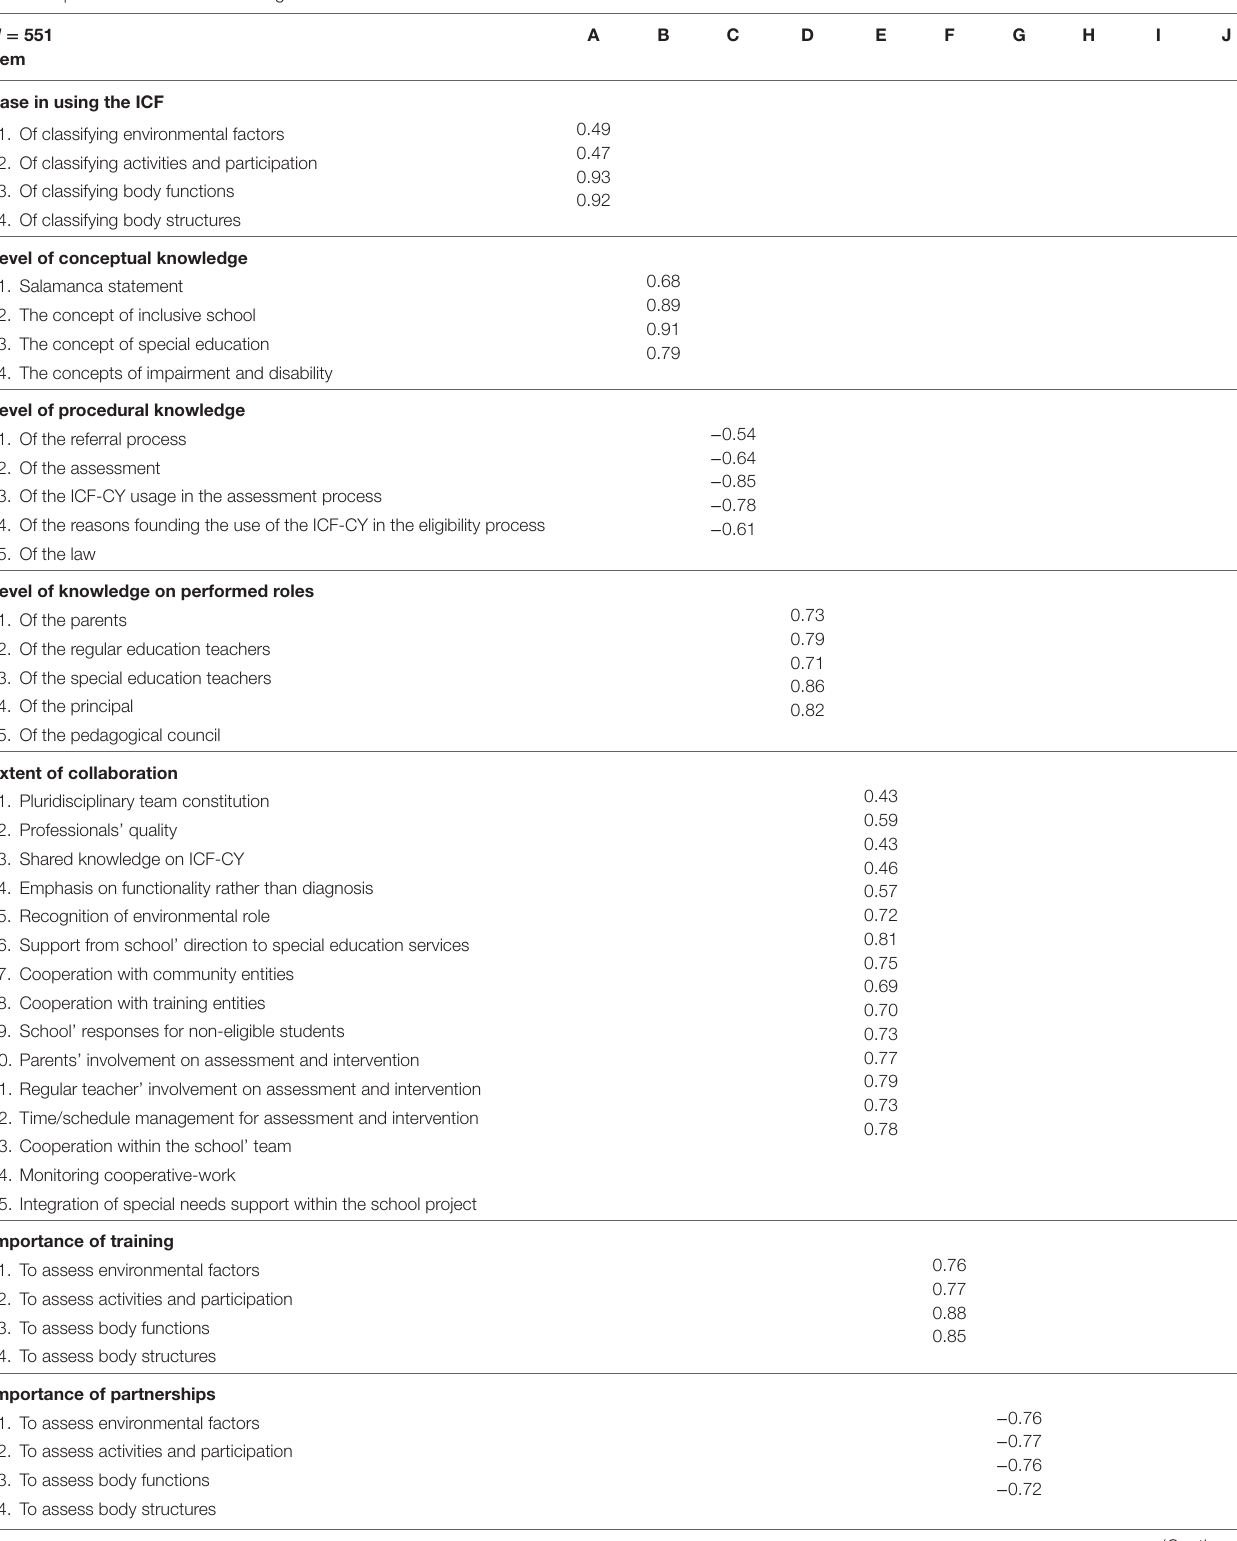
Table 3 | Questionnaire’ items